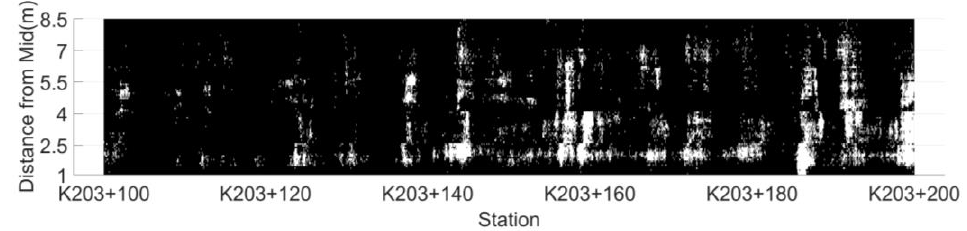
Figure 10. Physical engineering test. ( a ) Construction of the lower layer of asphalt. ( b ) Strip agglom- eration area of low and high compaction level aggregates on the surface. ( c ) 3D GPR scanning. ( d ) Void ratio measurement in low compaction level segregation risk area.